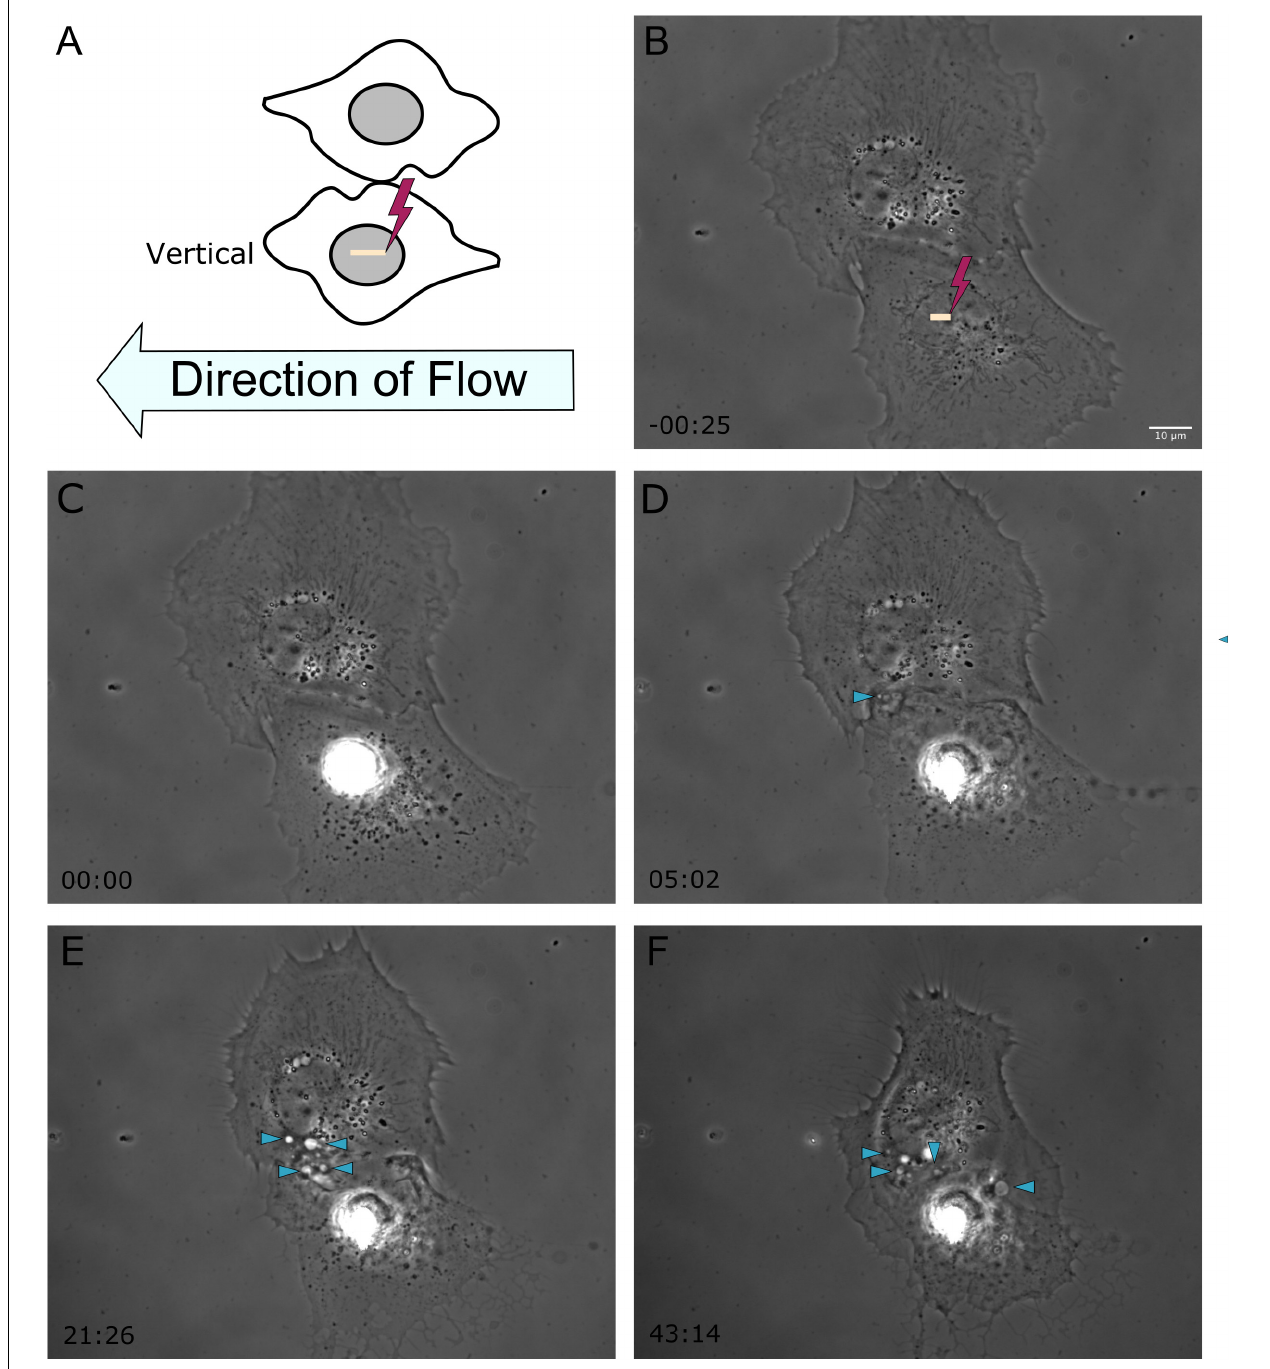
FIGURE 2 | Shear stress was applied from right to left on astrocytes located vertical to one another, represented in frame (A) . The yellow ROI demarcates the position of photolysis in image (B) , acquired 25 s prior to laser exposure. The irradiated cell in this example is located below the observed responding astrocyte. (C–F) Phase contrast images show the initiation of phagocytosis and the formation of vesicles in the vertically positioned cell, with vesicles highlighted by blue arrow heads in images (D–F) , corresponding to 5 to 43 min post-photolysis.